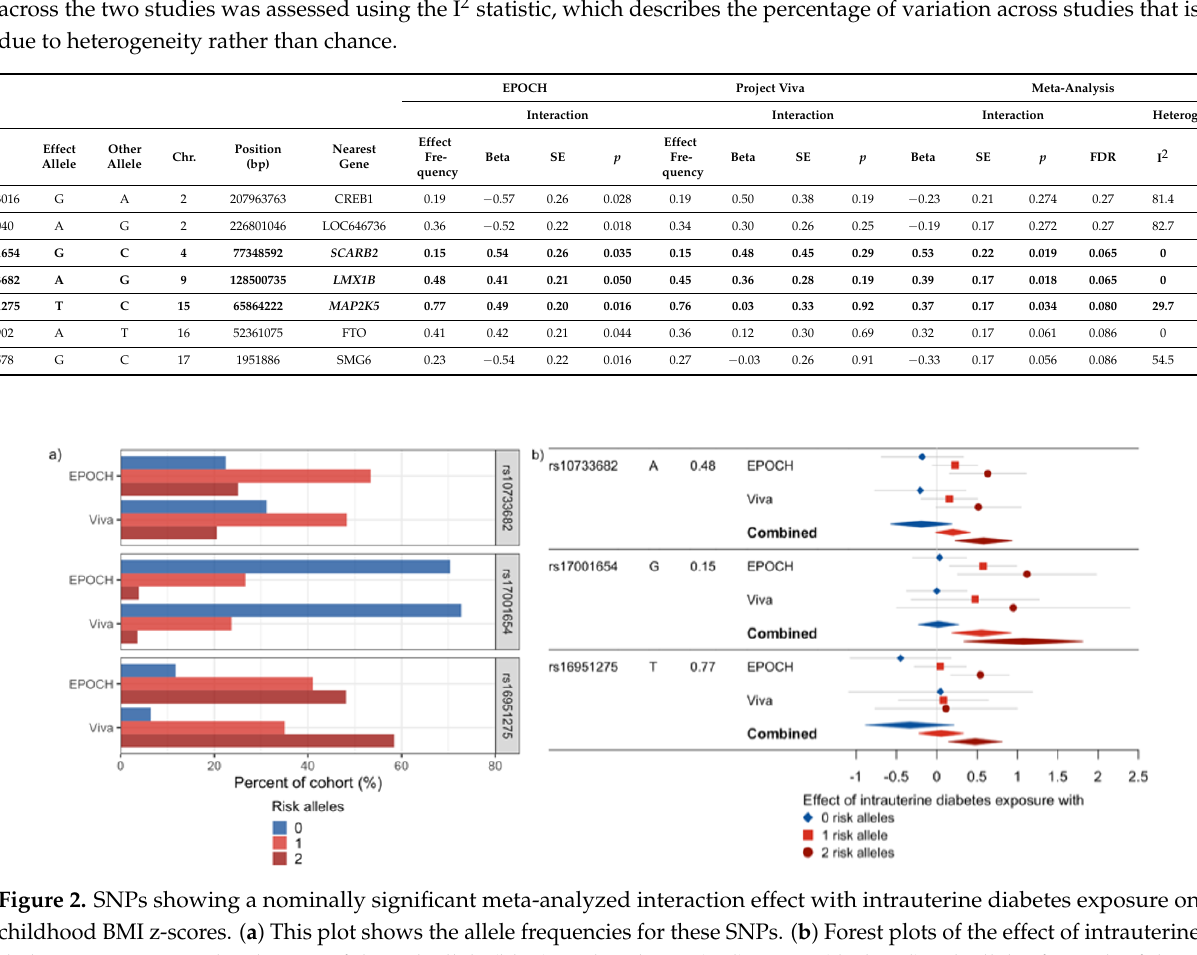
Figure 2. SNPs showing a nominally significant meta-analyzed interaction effect with intrauterine diabetes exposure on childhood BMI z-scores. ( a ) This plot shows the allele frequencies for these SNPs. ( b ) Forest plots of the effect of intrauterine diabetes exposure in the absence of the risk allele (blue), and with one (red) or two (dark red) risk alleles for each of these SNPs in EPOCH, Project Viva, and the meta-analysis of the combined studies. The left side of the plot shows the SNP, the risk allele and its frequency, and the study. Table 3. Interactions between the genetic risk scores (GRSs) and intrauterine exposure to maternal diabetes in relation to the BMI z-scores in the EPOCH cohort. This table shows the regression results for the interaction terms between the GRSs and intrauterine diabetes exposure statuses from the regression models of the BMI z-score in the EPOCH cohort (controlling for birthweight and the first three genetic principal components). Weighted and unweighted GRSs were calculated for (i) all 95 BMI-associated SNPs examined in this study and (ii) the subset of eight SNPs showing nominally significant interactions with intrauterine diabetes exposures in EPOCH.